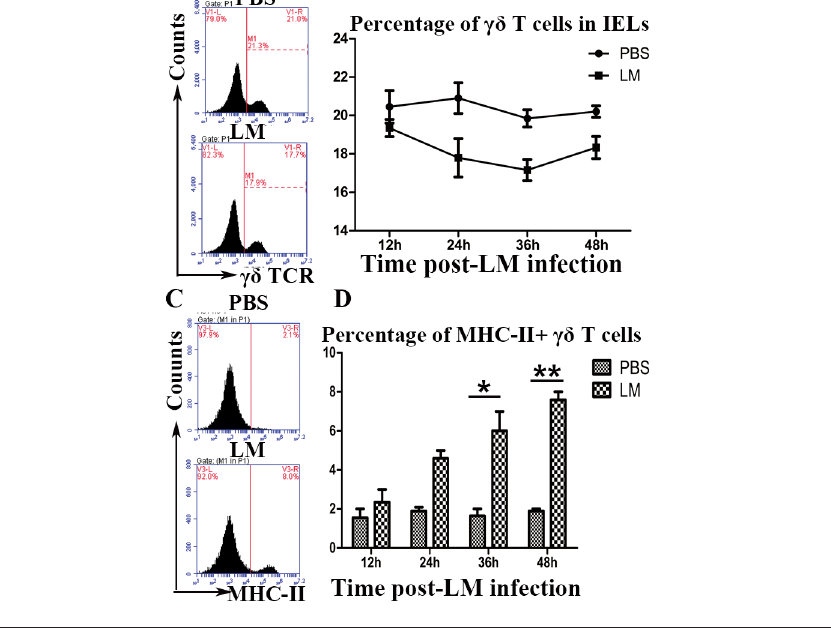
Figure 7. L. monocytogenes infection activated the expression of MHC-II molecules on γδ T cells. FCM analysis of percentage of γδ T cells in mouse IEL (A) and MHC-II + γδ T in γδ T cells (C) after intragastric administration with L. monocytogenes for 48 h. (B) Quantitation of the percentages of γδ T cells in mouse IELs. (D) Quantitation of the percentages of HLA-DR + γδ T cells in γδ T cells (gated in γδ T cells). Data are shown as mean ± SEM from four independent experiments. * P < 0.05. ** P <